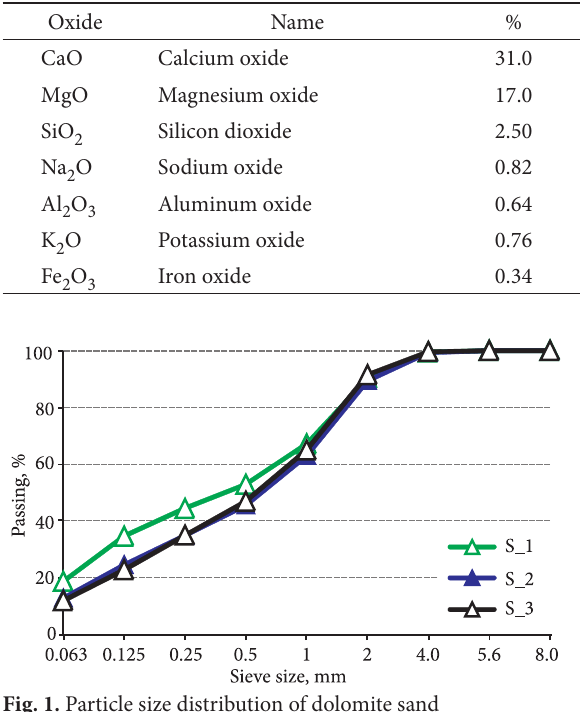
table 1. Chemical properties of dolomite sand waste